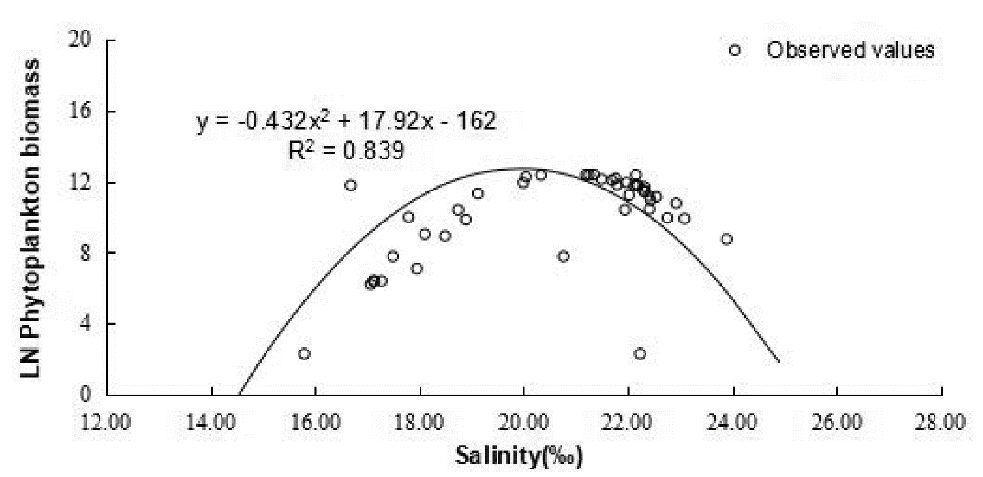
Figure 7. Quadratic fitting of salinity: The quadratic curve y = − 0.432 x 2 + 17.92 x − 162 fits well with the natural logarithm of measured phytoplankton cell density. R 2 value is 0.839.